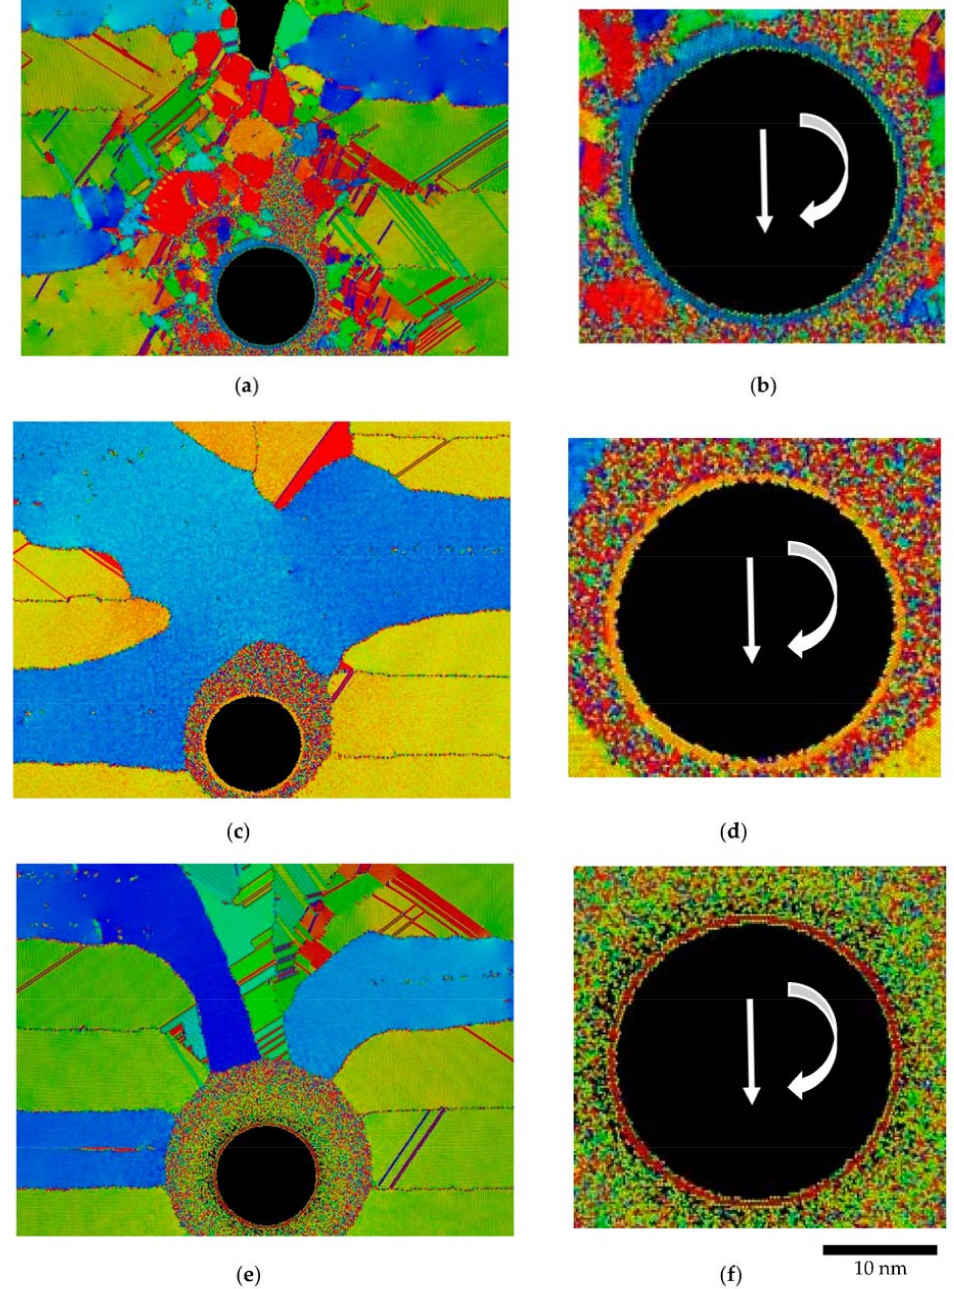
Figure 4. Crystallography after welding for 1.27 M atoms at ( a , b ) 0.01 (ps − 1 )/100 (m/s), ( c , d ) 0.01 (ps − 1 )/10 (m/s), and ( e , f ) 0.1 (ps − 1 )/10 (m/s) at a mean temperature of 550 K. The colors indicate the orientation of the atoms except black, which represents air/pin. Picture ( a ) depicts remarkable nano-twinning attributed to nano-crystalline aluminum and extreme strain rates, with this plasticity mechanism being less relevant in ( c , e ). White arrows indicate the advancing and rotating